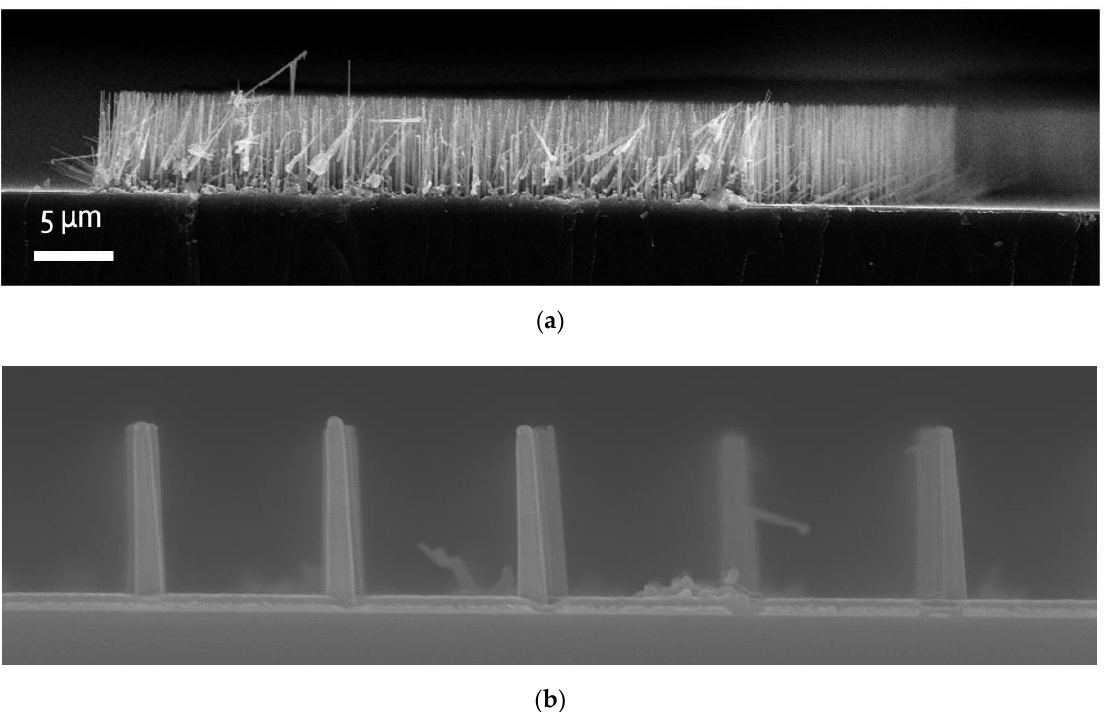
Figure 11. SEM Side views. ( a ) Nanoscale chemical templating (NCT), showing controlled growth of a group of Si nanowires. ( b ) Controlled growth of single Si nanowires at each opening; arrow 1 shows the thin oxidized layer of Al (Al 2 O 3 ), and arrow 2 points to the planer growth of Si; the average nanowire length is 5 µm.